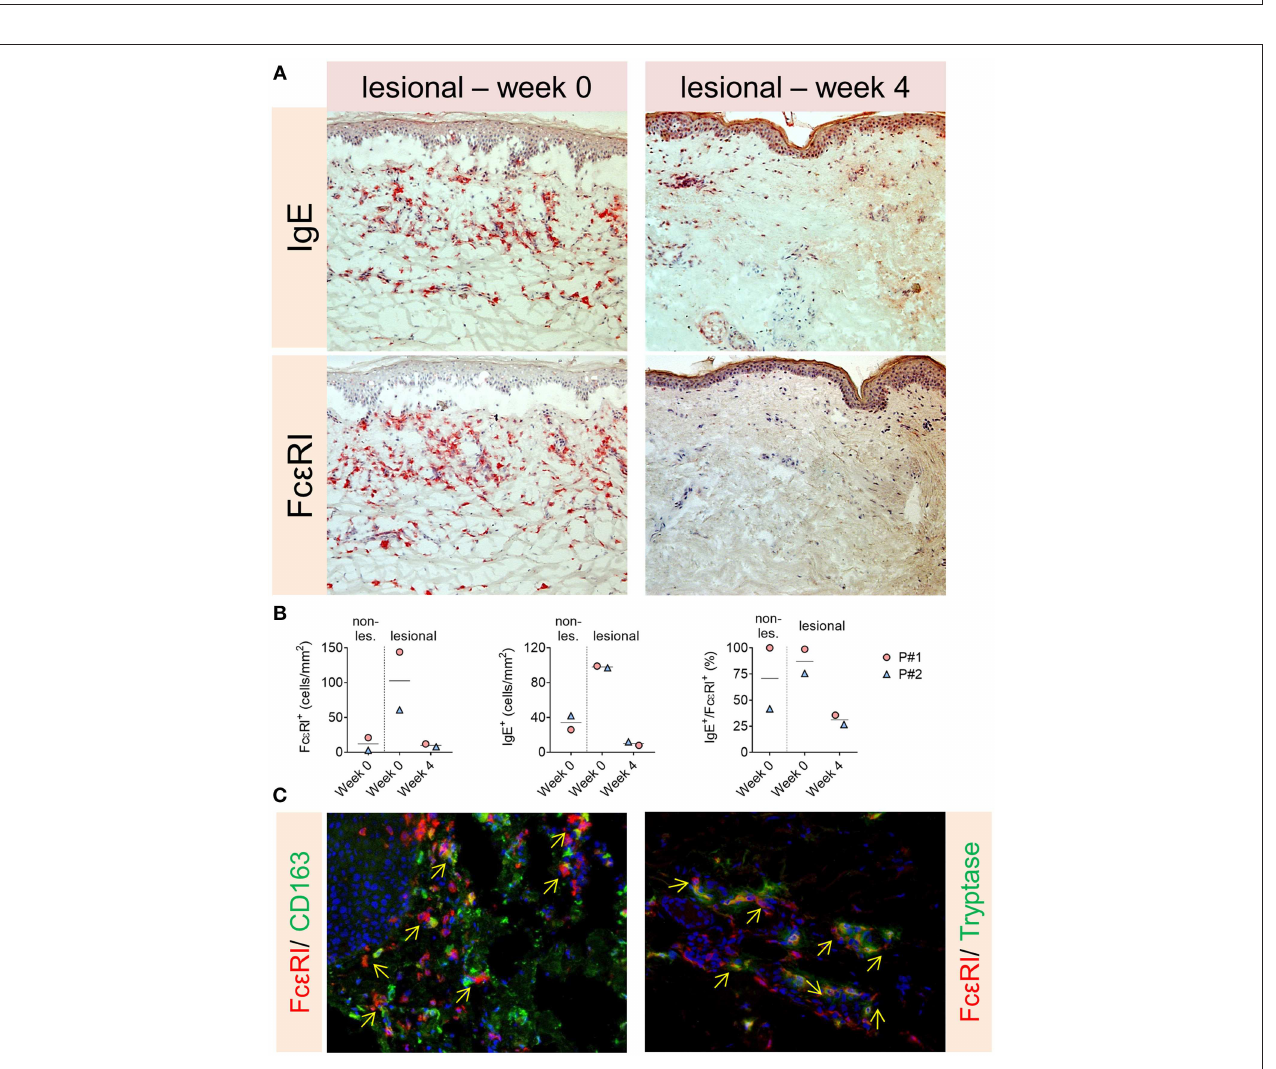
FIGURE 3 | (A,B) Significant reduction of IgE + and Fc ε RI + cells in dermis in the immunohistochemistry stainings of the patients after 4 weeks of omalizumab treatment. (C) Both mast cells and APCs were found to express Fc ε RI in lesional skin (arrows show double positive cells).